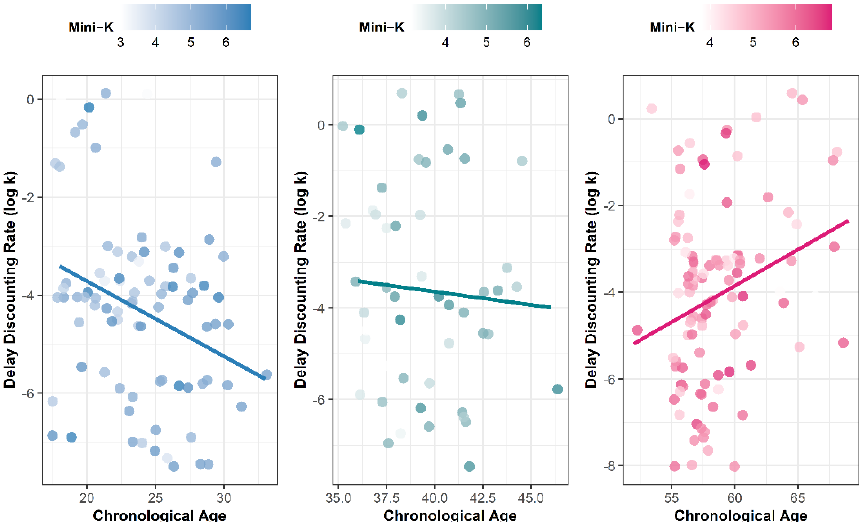
Figure 1. Blue ( left ), green ( middle ) and red ( right ) represent young adults, middle-aged, and older adults, respectively. Each straight line represents the fitted regression line for predicting delay discounting rate by chronological age using the MM-estimator. In order to prevent overplotting, the points were slightly jittered.